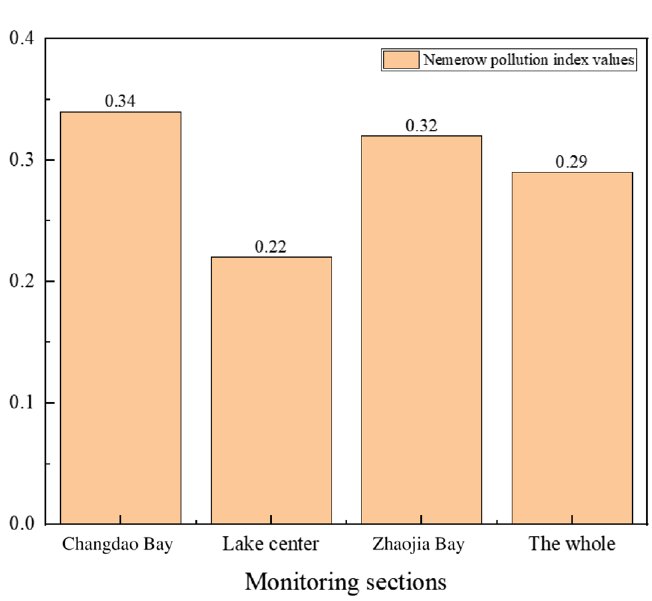
Figure 4. Comparison of Nemerow pollution index of various monitoring sections of Lugu Lake in